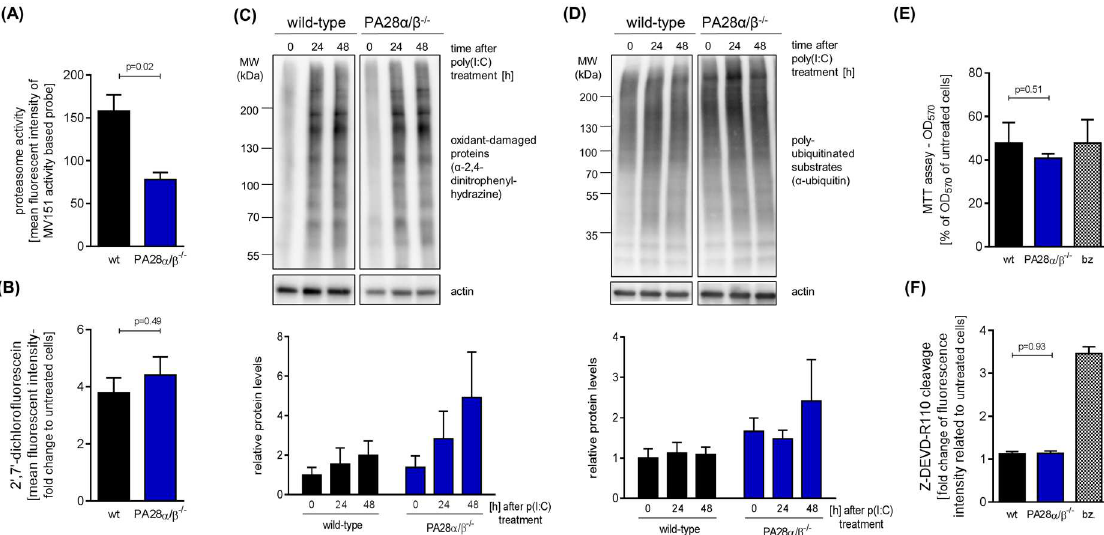
Fig 2. Protein homeostasis in TLR3-activated bone marrow derived macrophages. (A) Splenocytes freshly isolated from 8–12weeks old wild-typeand PA28 αβ − / − mice were incubatedwith MV151 activity based probe (ABP). Binding of ABP was detected by flow cytometry and is shownas mean fluorescence intensity (means + SEM, n = 4 for wild-type,n = 3 for PA28 α / β − / − , 2 independent experiments). Bone marrow derived macrophages (BMM) were obtained from 8–10 weeks old wild-typeand PA28 αβ − / − mice. BMMs were treated with poly(I:C). (B) After 24 hours of stimulation,cells were incubatedwith DCFH-DA to measurereactive oxygen species (ROS). ResultingDCF fluorescence was detected by flow cytometry and mean fluorescence intensity is shown as fold changerelative to untreated cells (means + SEM, n = 3). (C) BMM lysates obtainedafter 0, 24, and 48 hours of treatment with poly(I:C) were subjectedto Oxyblot analysis(depictedresults were obtained from the same membrane). Results of a densitometric analysisare shown as relative intensities in comparisonto untreated wild-typeBMM (means + SEM, n = 3, no significantdifferences were detected). (D) Total cell lysates obtainedafter 24 and 48 hours of poly(I:C) treatment were subjectedto Western blottingof poly-ubiquitinated proteins and actin (depicted results were obtainedfrom the same membrane). Densitometric analysiswas performed and levels of poly-ubiquitin conjugates are shown as relative intensitiesin comparisonto untreated, wild-typeBMM (means + SEM, n = 3, no significantdifferences were detected). Actin served as a loadingcontrol and was used for normalization. Cellularviabilitywas assessed 24 hours after poly(I:C) treatment by (E) MTT assay and by (F) Apo- ONE assay presentedas fold changerelative to untreatedwild-typecells (means + SEM, n = 3). In both assays bortezomib (bz) treatment served as a positive control.